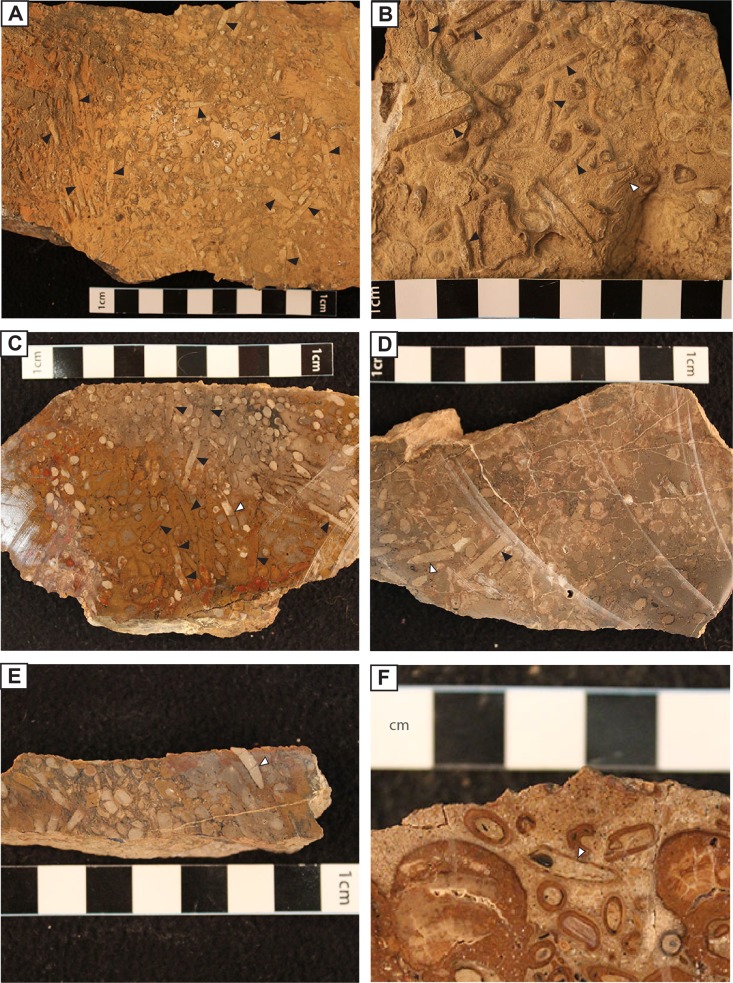
Caddisfly cases on the hand sample photos.(A) Straight (black arrow) caddisfly cases on the hand sample. (B) Straight (black arrow and curved (white arrow) caddisfly cases on the hand samples. (C) Straight (black arrow) and curved (white arrow) caddisfly cases on the polished sample. (D) Straight (black arrow) and curved (white arrow) caddisfly cases on the polished sample. (E) Curved (white arrow) caddisfly case on the polished sample. (F) Curved (white arrow) caddisfly case on the polished sample.